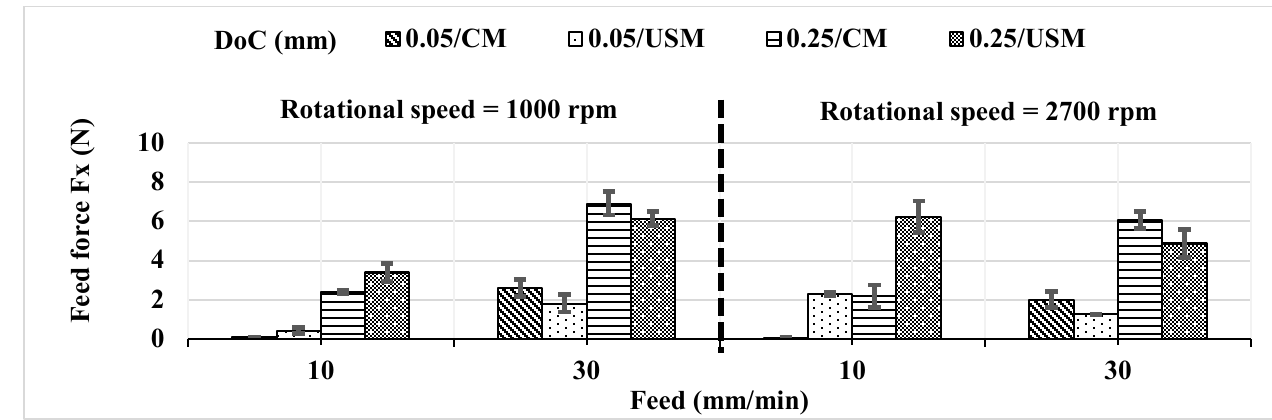
Figure 18. Cutting force (Fx) in feed direction at different cutting parameters.